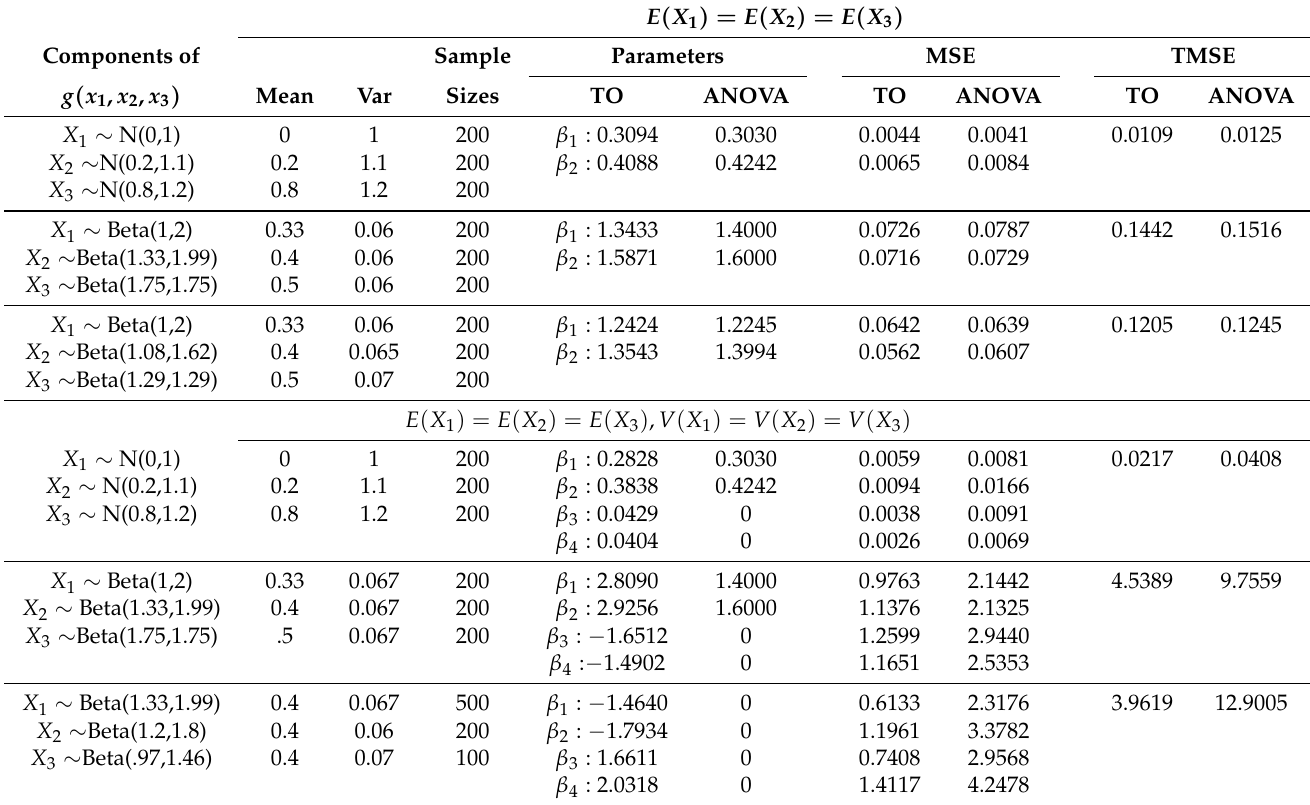
Table 1. Mean square errors of the β